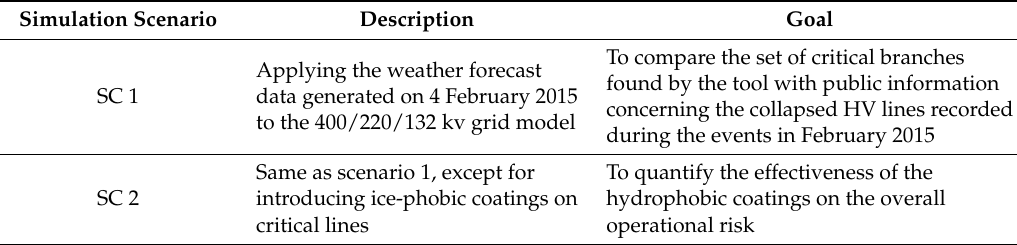
Table 2. Summary of simulation scenarios and their goals.